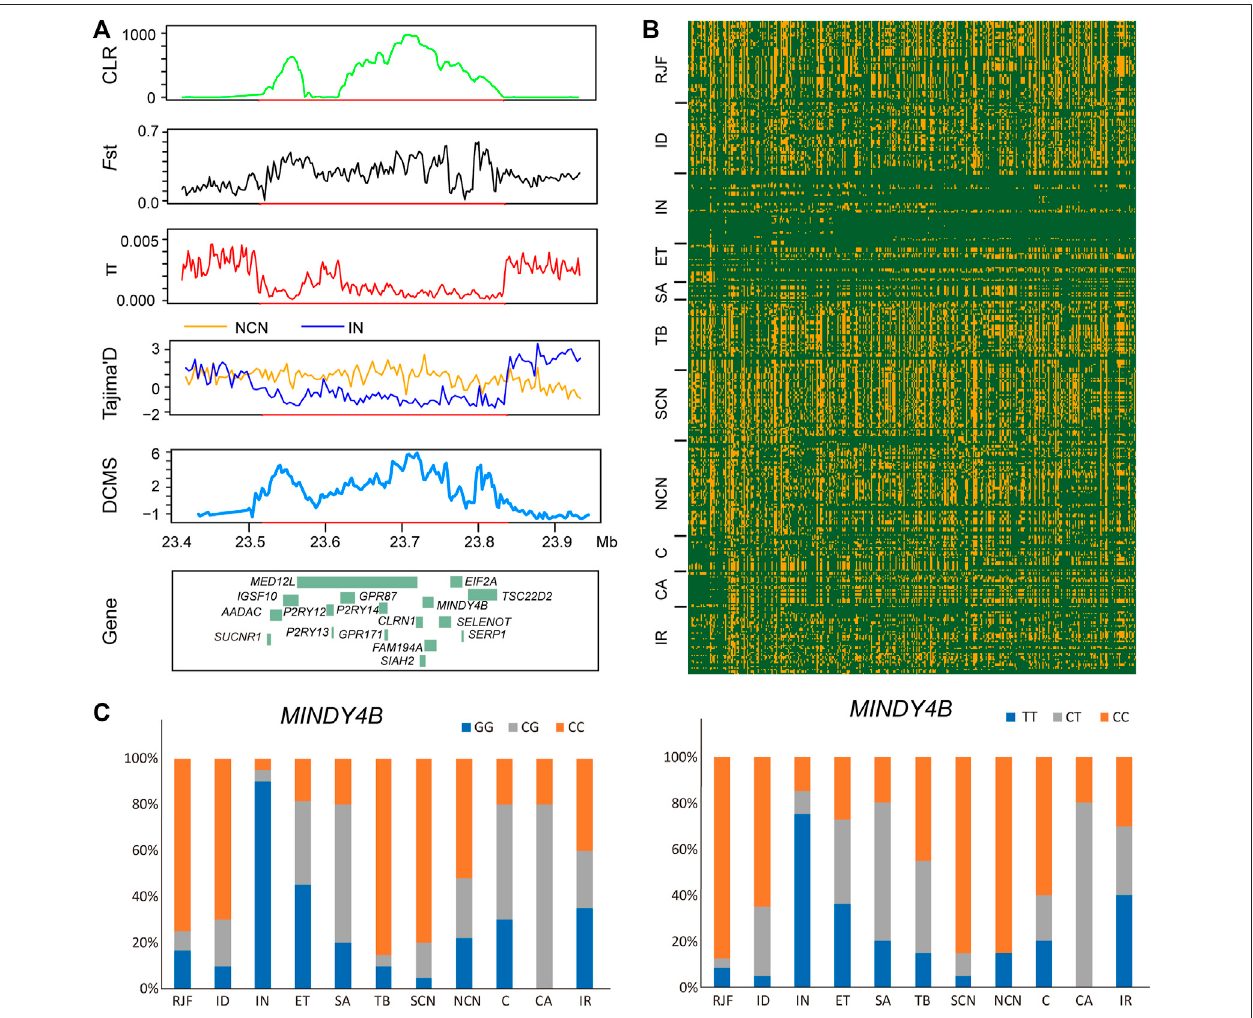
FIGURE 4 | A putative selective sweep region associated with hot tolerance in Indian chickens. (A) fi ve sweep statistics plotted over a 280-Kb region on chromosome 9 detected by Indian chickens. From top to bottom, the vertical axis shows the values of CLR, F st, π , Tajima ’ s D, and DCMS. (B) the degree of haplotype sharing around the region. (C) allele frequency of the mutant MINDY4B loci. Blue, orange, and gray represented homozygous mutant, heterozygous mutant, and homozygous wild type, respectively.